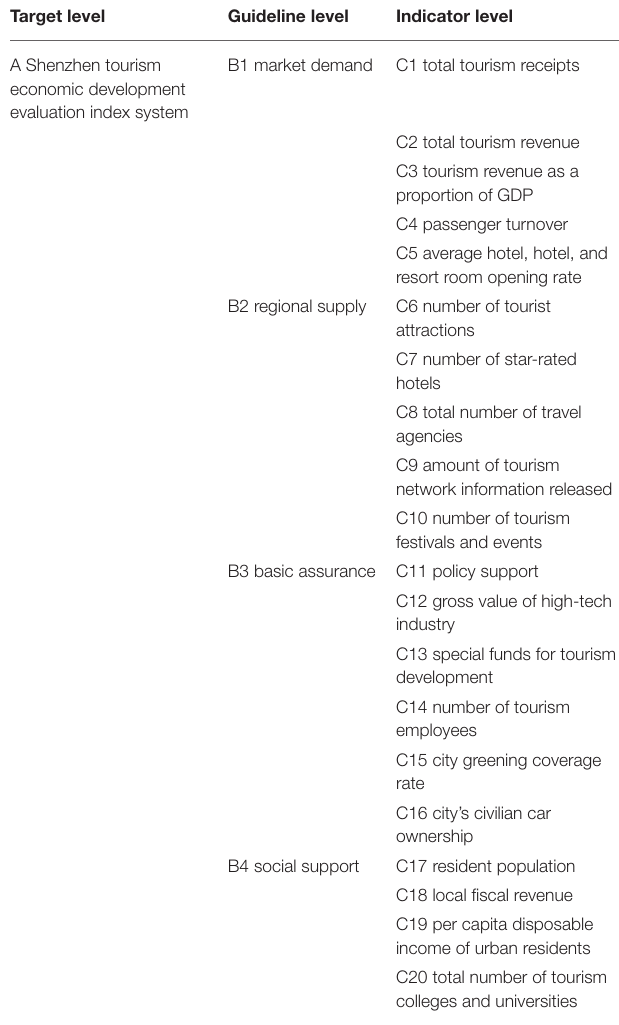
TABLE 1 | Shenzhen tourism economic development comprehensive evaluation index